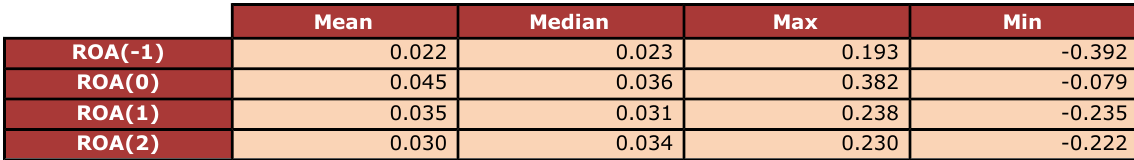
Table 3. Distribution of time series of acquiring firm’s performance around